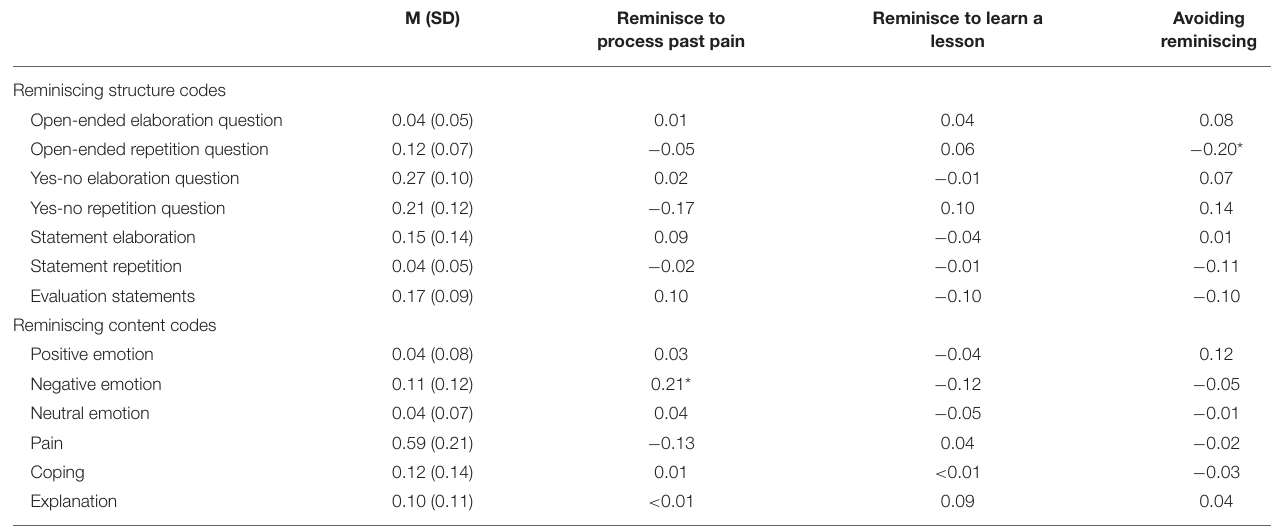
TABLE 2 | Correlations between parental beliefs about functions of reminiscing and parent use of reminiscing codes. M